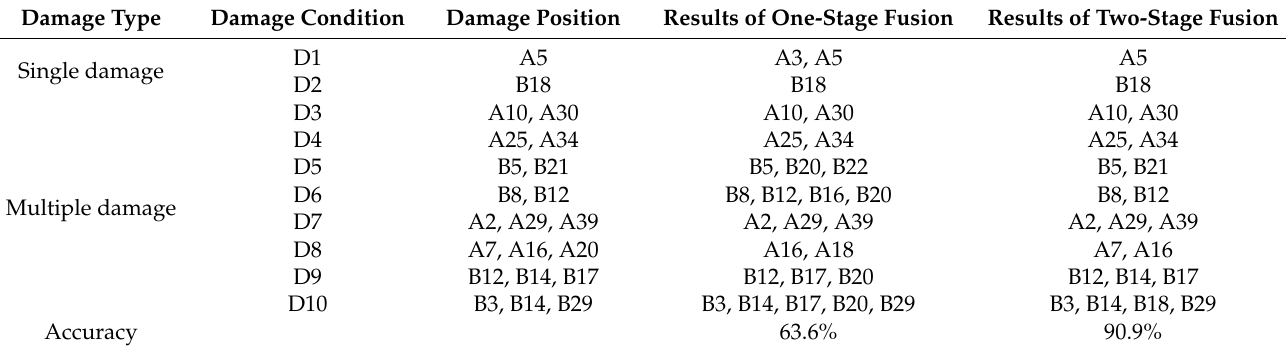
Table 3. The damage identification results of multi-index data